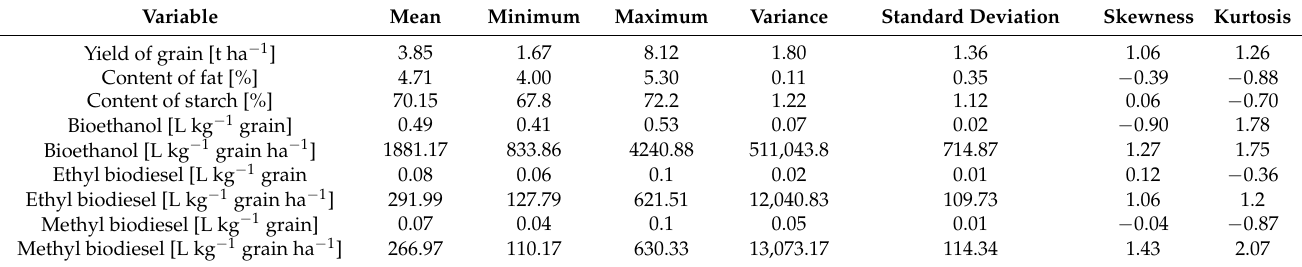
Table 3. Values of statistical parameters for analyzed